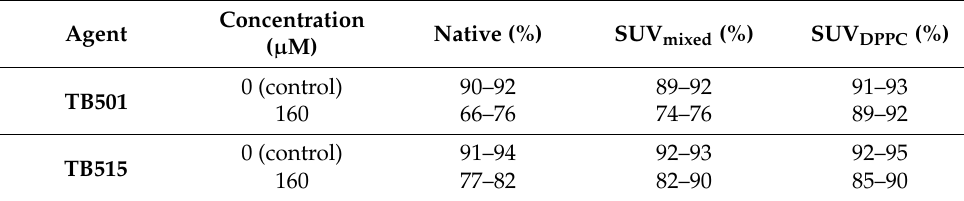
Table 2. Characterization of in vitro cytotoxicity for two antitubercular agent candidates (TB501 and TB515) on MonoMac-6 human monocytic cell line measured by flow cytometry (set on forward and side scattered (FSC, SSC); on two independent samples: duplicate); the ratio of living cells (%) with 160 µ M agents for native agents and liposomal formulations (in SUV mixed and in SUV DPPC ). (Control means the untreated cells.)